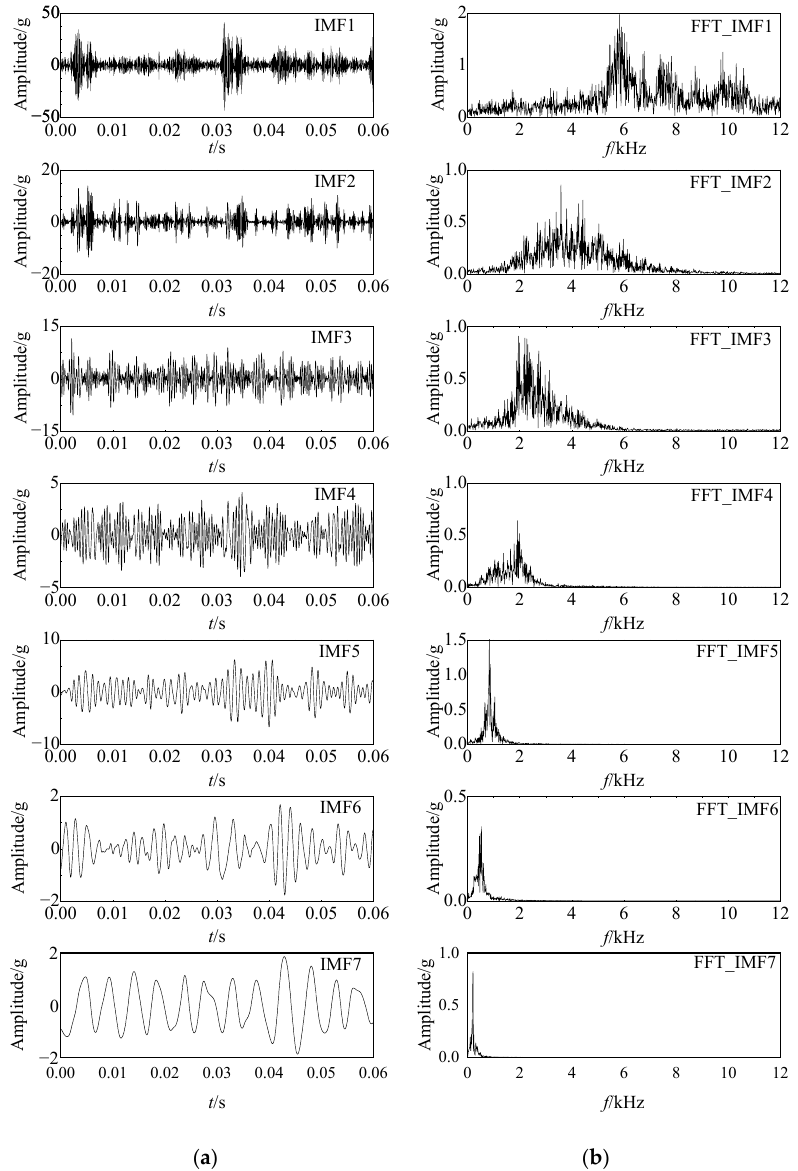
Figure 11. Decomposition results of the CEEMDAN: ( a ) time domain; ( b ) frequency domain.